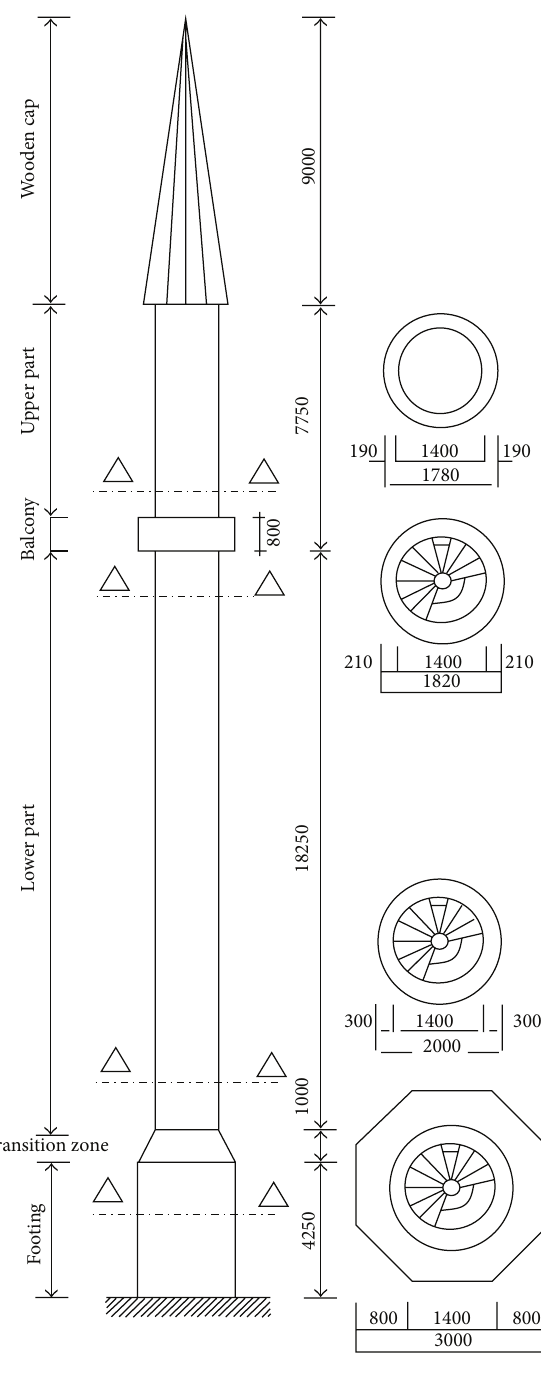
Figure 2: Geometrical and cross-sectional properties of the minaret (all dimensions are in mm)